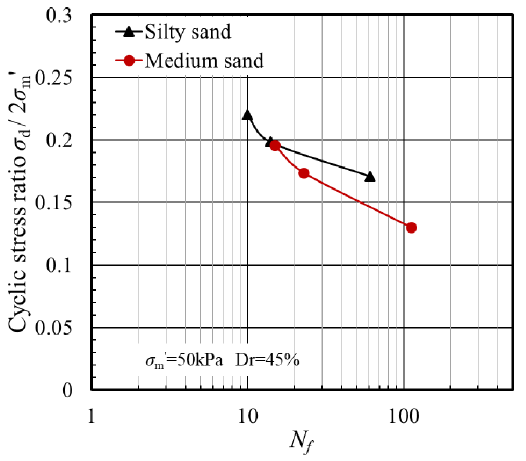
Figure 7. Cyclic strength curve of silty and medium sand.